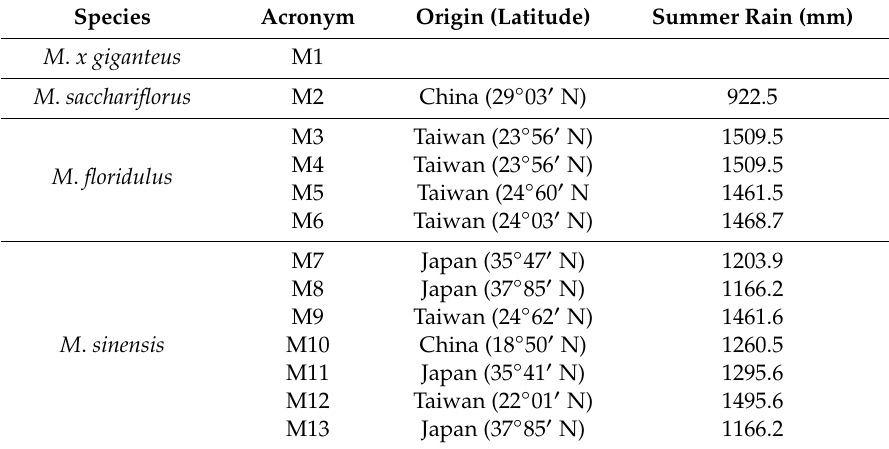
Table 1. Latitude and summer rainfall (from Equinox to Equinox) for wild collected Miscanthus spp. genotypes used in this